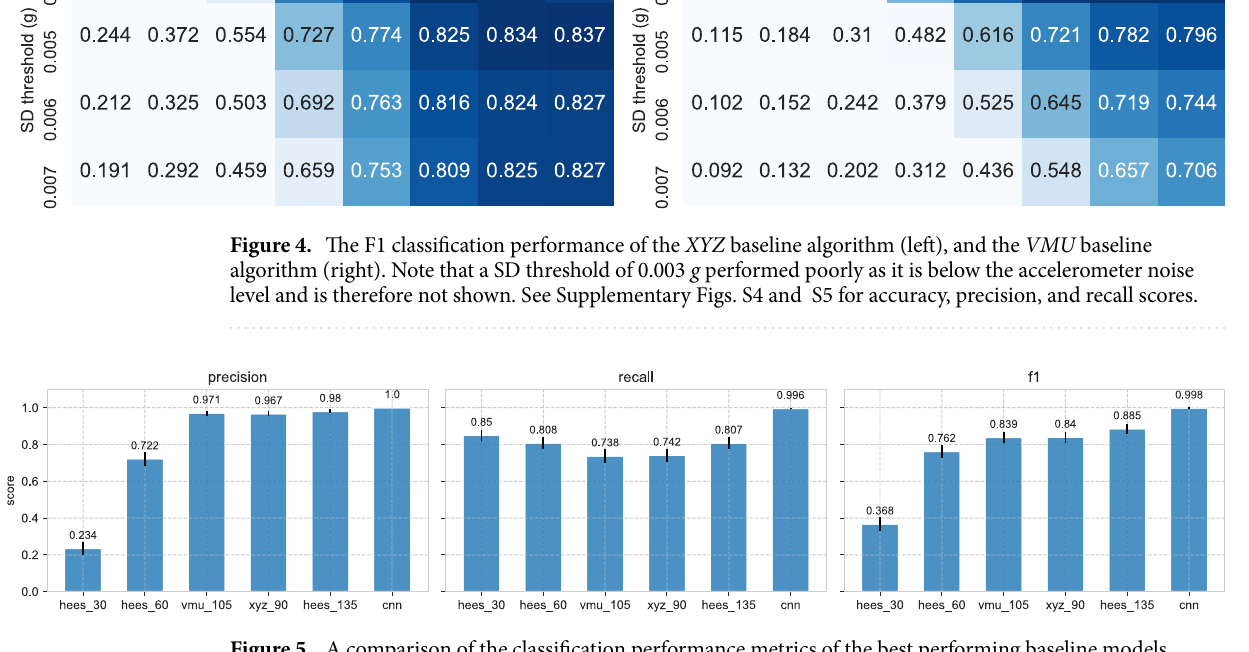
Figure 5. A comparison of the classification performance metrics of the best performing baseline models XYZ_90 (i.e. calculating the standard deviation of the three individual axes and an interval length of 90 mins), VMU_105 (i.e. calculating the standard deviation of the VMU and an interval length of 105 mins), the HEES_30 algorithm with a 30 mins interval, the HEES_60 with a 60 mins interval, the HEES_135 with tuned hyperparameters and a 135 mins interval, and the proposed CNN algorithm. Error bars represent the 95% confidence